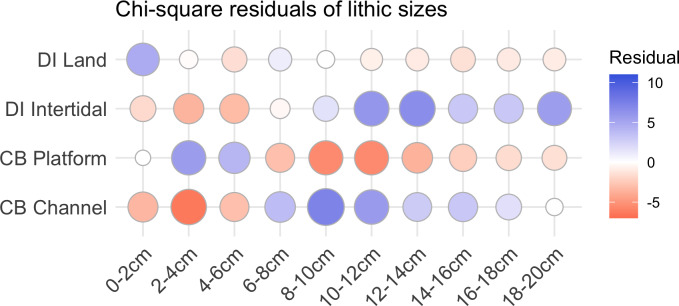
Residual plot for the Pearson’s chi-squared test of artefact sizes from the Cape Bruguieres and Dolphin Intertidal assemblages, using the ggcorrplot package [64] in R.Blue circles indicate an over-representation, and red circles indicate an under-representation. A Pearson’s chi-squared test shows this difference is statistically significant (X2 (df = 9, N = 881) = 505.27, simulated p<0.001) with a moderate to strong effect size (V = 0.44) [63].